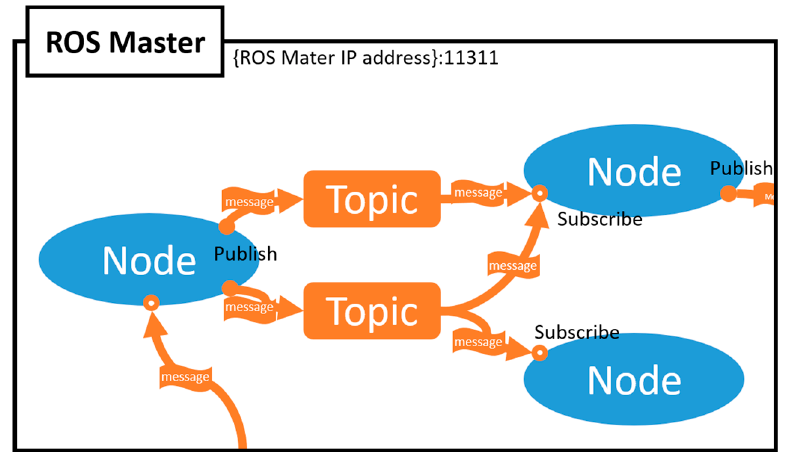
Figure 4. Robot operating system (ROS) structure.